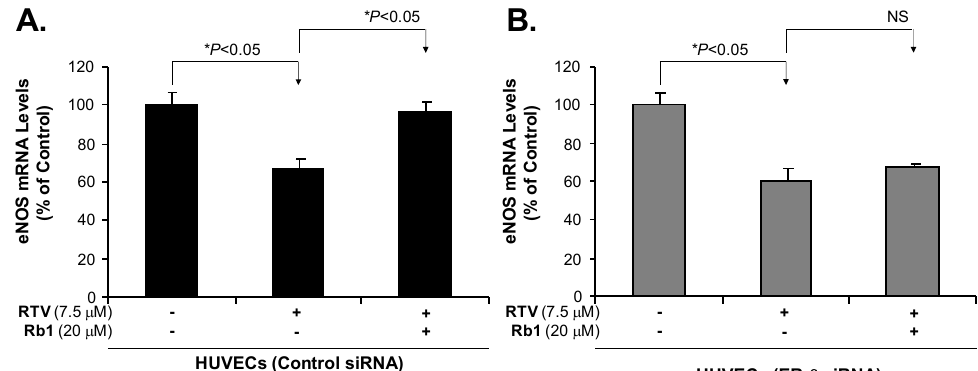
treated cells was compared with that of the control; ( B ) mRNA levels of eNOS (real time PCR) in HUVECs. eNOS mRNA levels were standardized with untreated control cells as 100%; ( C ) Protein levels of eNOS (Western blot) in HCAECs; ( D ) mRNA levels of eNOS (real time PCR) in HCAECs. Student’s t -test was used to compare the control with the treated groups. n = 3. * p < 0.05.